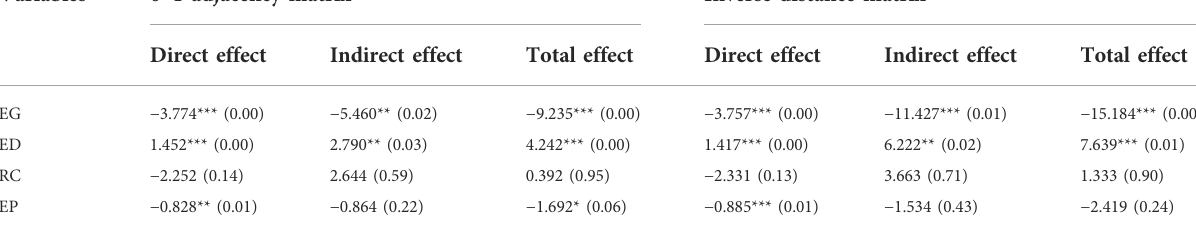
TABLE 10 Decomposition of the spatial spillover effect of ecological protection